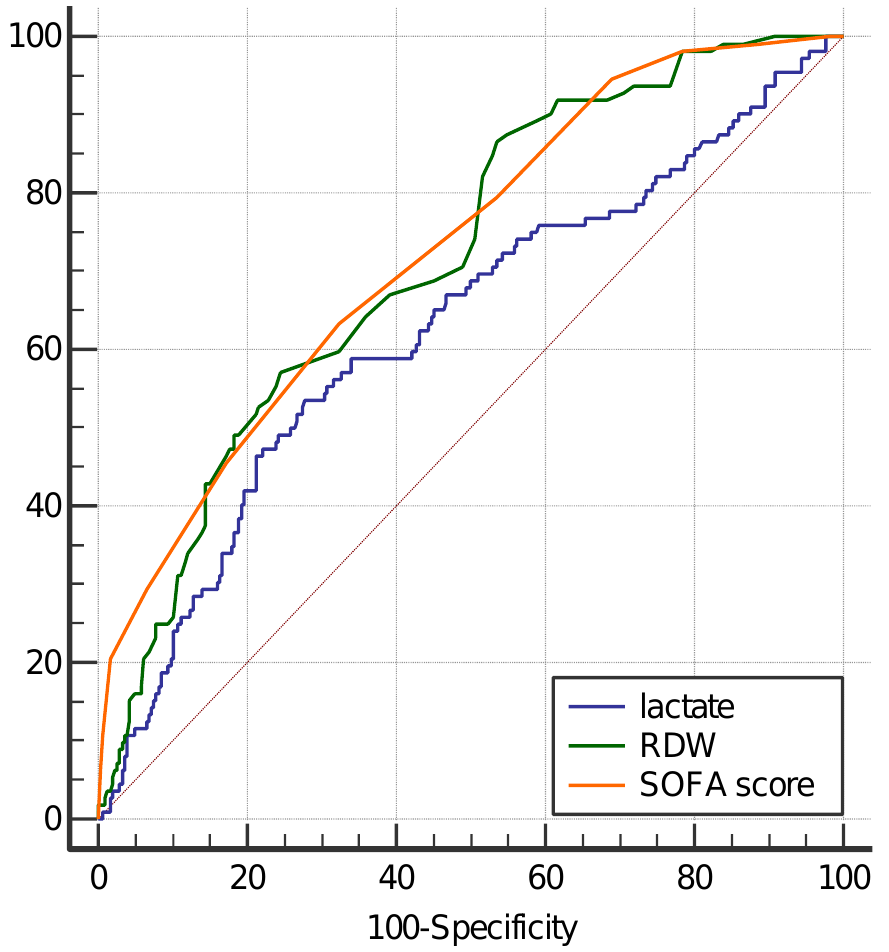
Figure 2. Receiver operating characteristic curves for 30-day in-hospital mortality predicting ability of SOFA score, initial serum lactate, and RDW levels in patients with